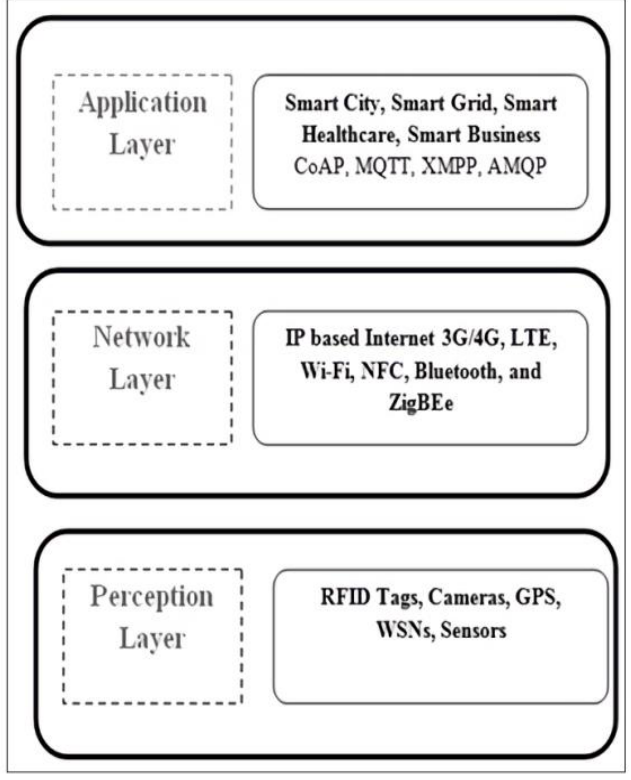
Figure 1. The layered architecture of IoT.